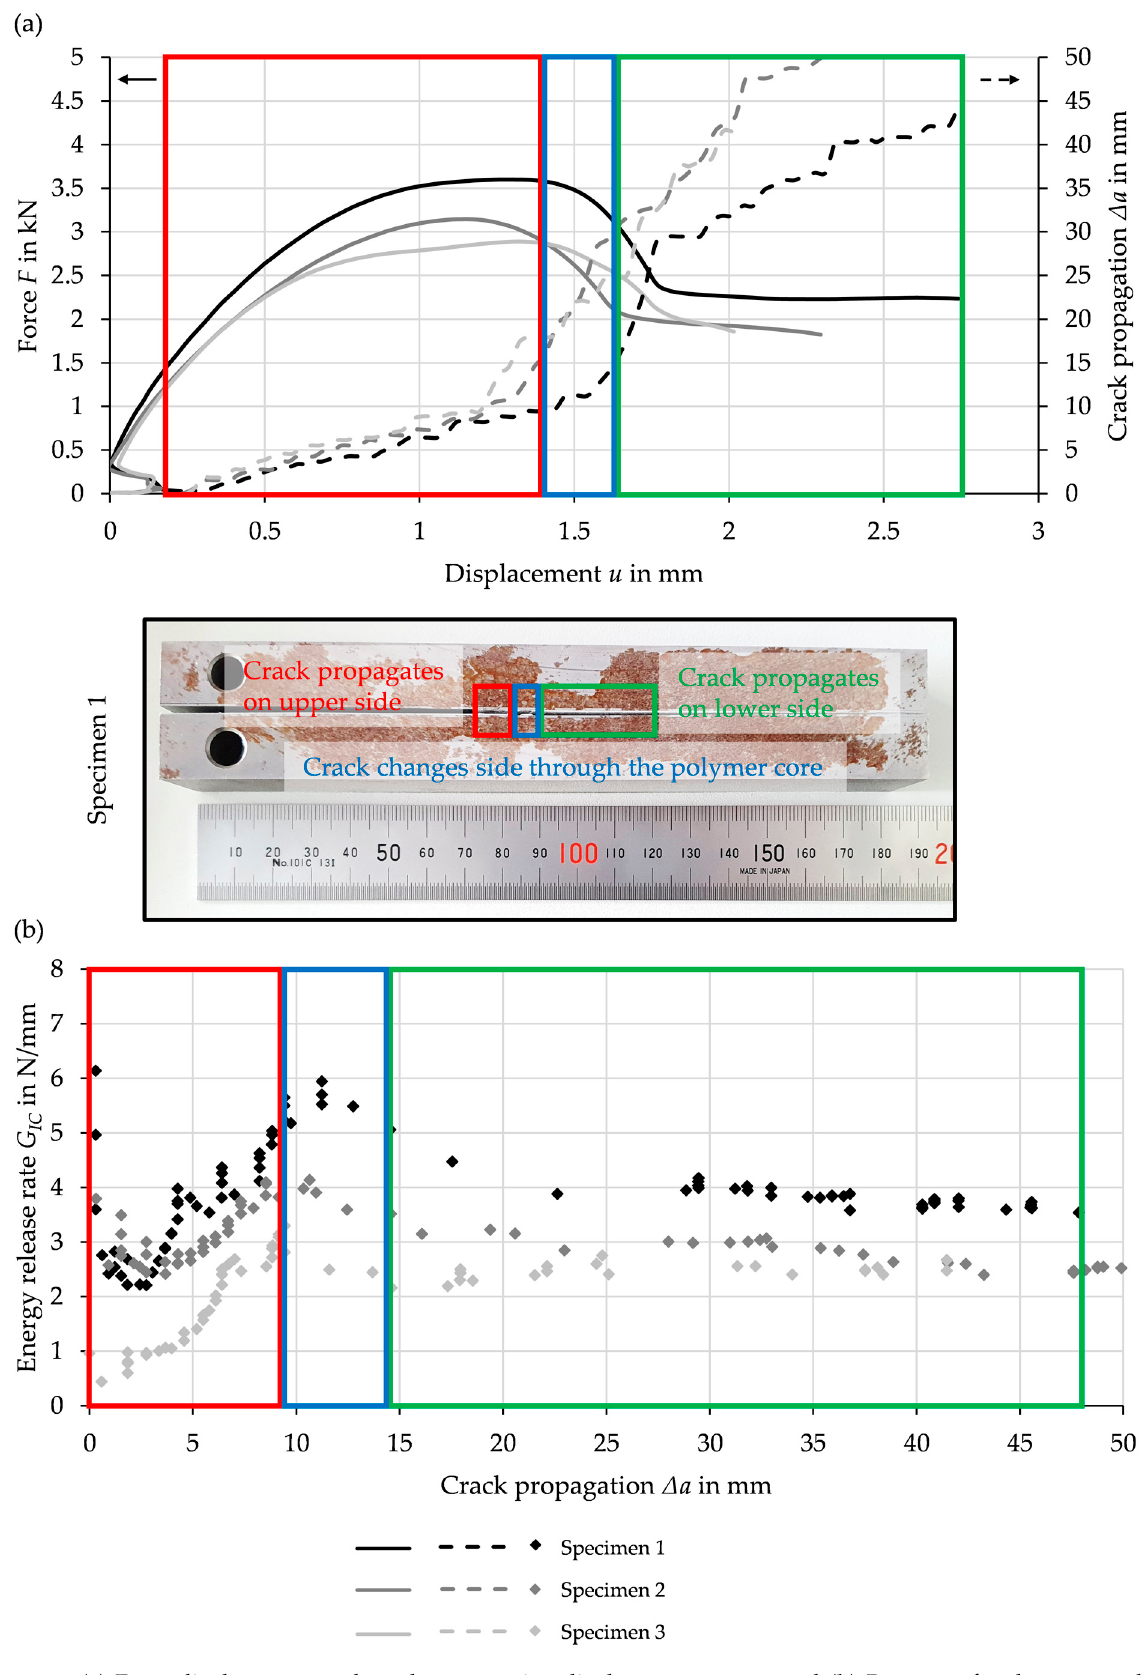
Figure 9. ( a ) Force-displacement and crack propagation-displacement curves and ( b ) R-curves, for three exemplary specimens; colored rectangles for specimen 1.